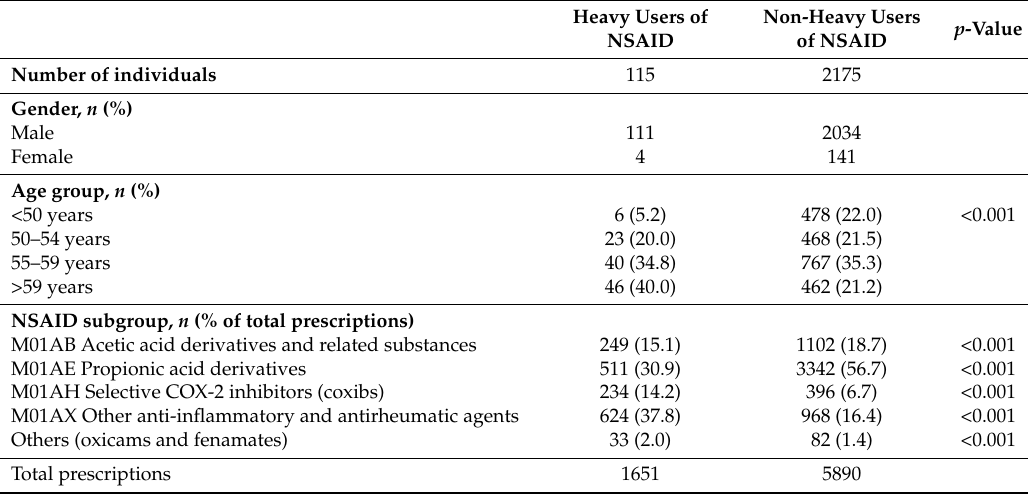
Table 3. Characterization of heavy users and non-heavy users of non-steroidal anti-inflammatory drugs.